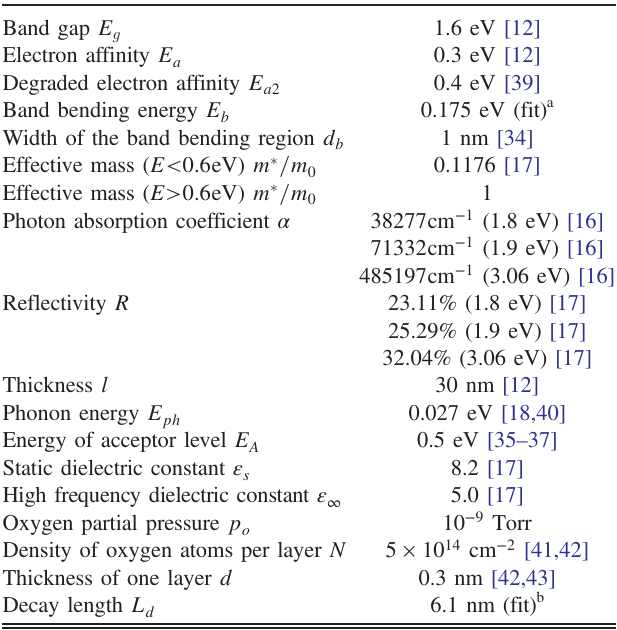
TABLE I. Parameter used for the case of Cs 3